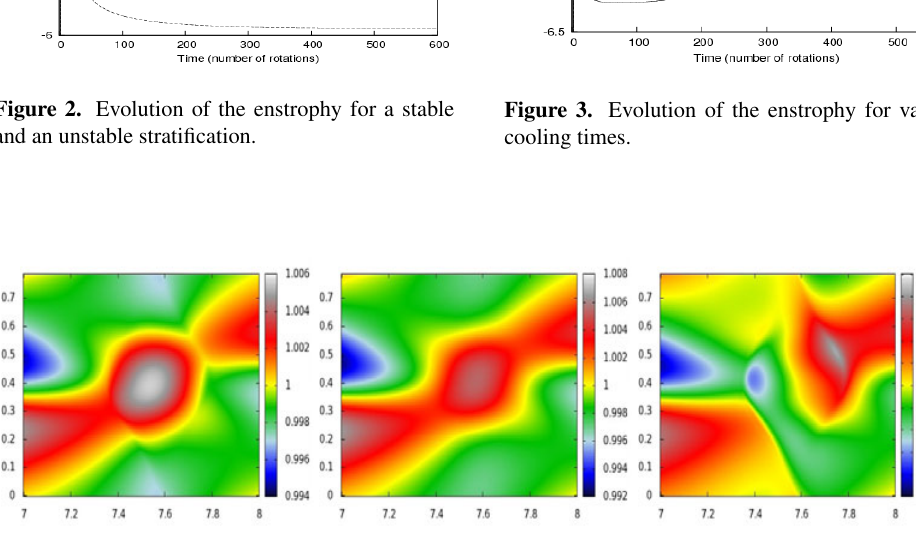
Figure 4. Structure of a baroclinic vortex after 600 rotations. From left to right: the density, the pressure and the temperature of the gas in the meridional plane,